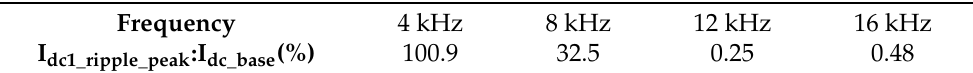
Table A1. Example relationship between the peak value of current ripple at different frequencies and base